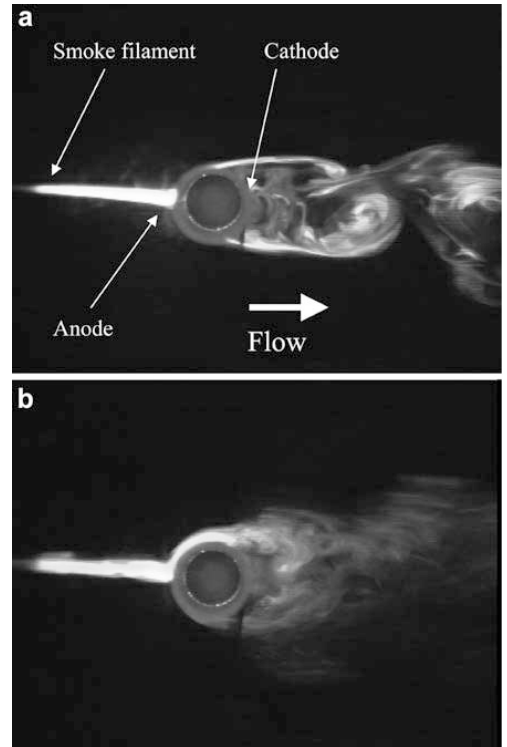
image of the generalized glow discharge. Figure 6. Smoke visualization of the instantaneous flow around a circular cylinder at Re D ≈ 2.5 × 10 3 Fig. 5a, b. Sequence of visualizations: a t = ) 0.04 s, U 0 =0.7 m/s. Fig. 4. Digitalized b t =1.56 s (electric field is applied at t =0), U 0 =0.7 m/s, D V=32 kV Plasma sheet contouring the cylinder surface, D V=34 kV before ( a ) and after ( b ) a plasma actuator was activated. Reprinted by permission from the work by the authors of [99], c (cid:13) Springer-Verlag,